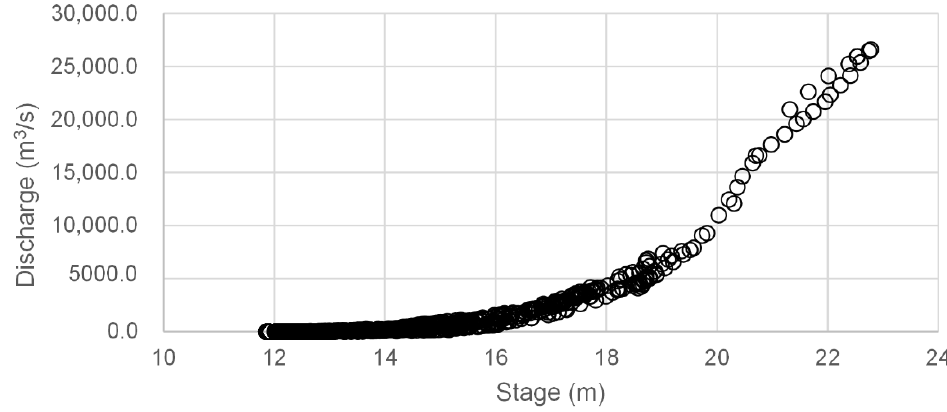
Figure 6. The relation between riverine surface area inundated with water and corresponding dis-